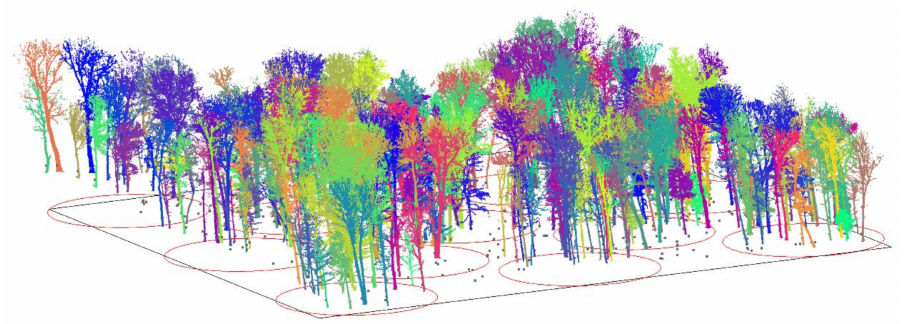
Figure 4. Illustration of the experimental design established for the study site. The field inventory included the geo-location of all trees (gray points) and delineation of all trees from the TLS point cloud within the 13 sample plots (colored